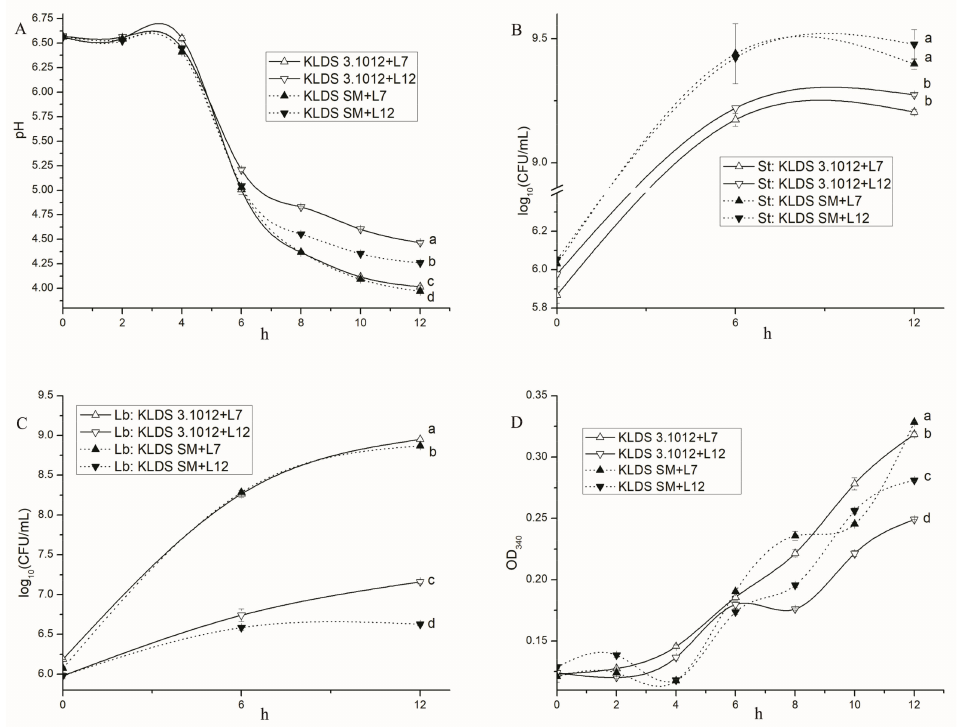
Figure 6. Comparison of technological properties of the four mixed cultures during milk fermentation: ( A ) pH curves of milk fermented by the four combinations; ( B ) Live counts of S. thermophilus in mixed culture during fermentation; ( C ) Live counts of Lb. bulgaricus in mixed culture; and ( D ) Proteolysis (OD340 nm) of milk fermented by the four